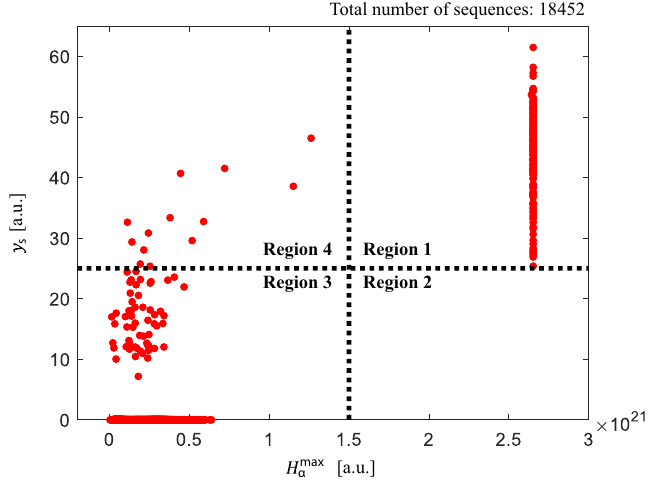
max α and y s plot for sequential input data.